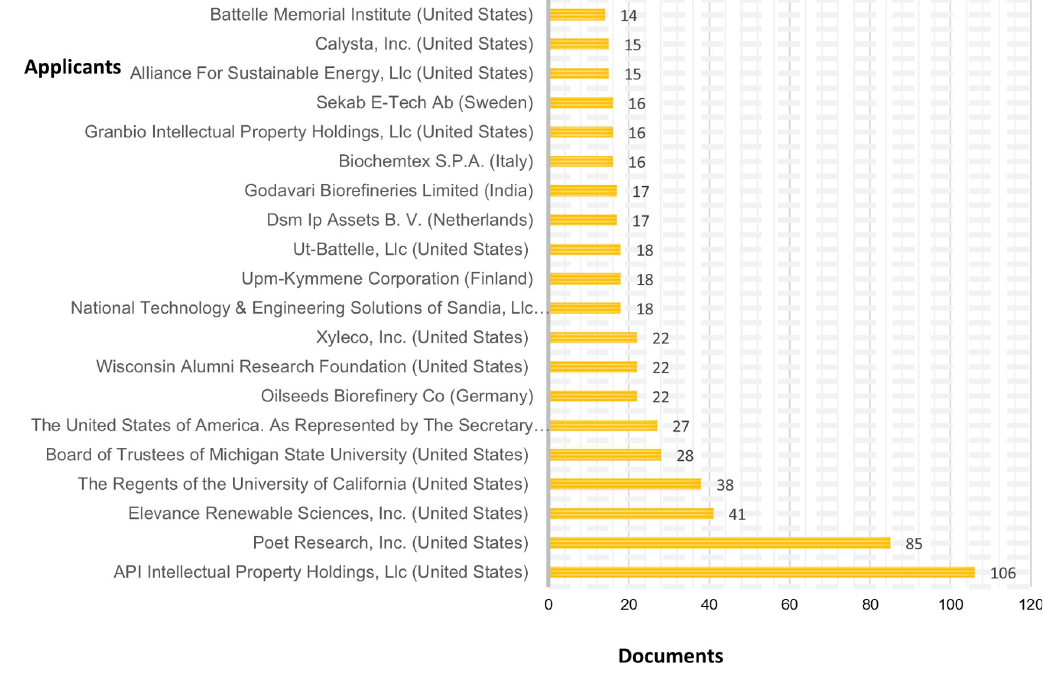
Fig 5. Top patent document applicants. Source: Prepared by the authors based on WIPO [28].